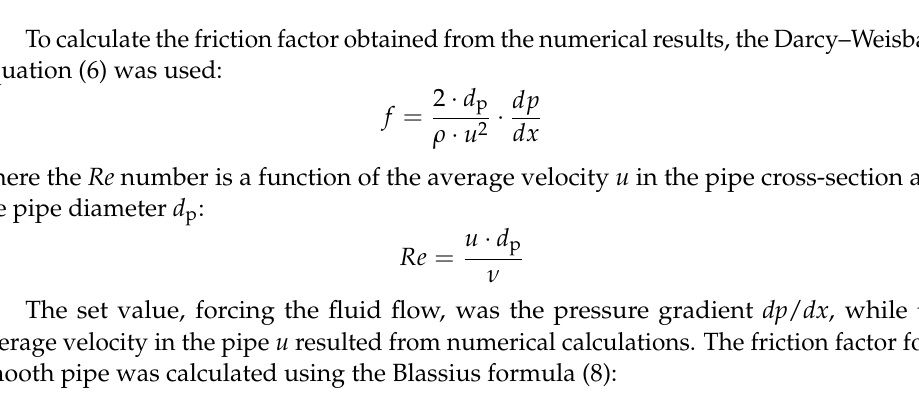
Figure 6. Velocity profiles in the symmetry plane for several dimensionless diameters D of the insert and the same number Re = 13,500. ( a ) D = 0.2, ( b ) D = 0.5, ( c ) D = 0.7, ( d ) D =